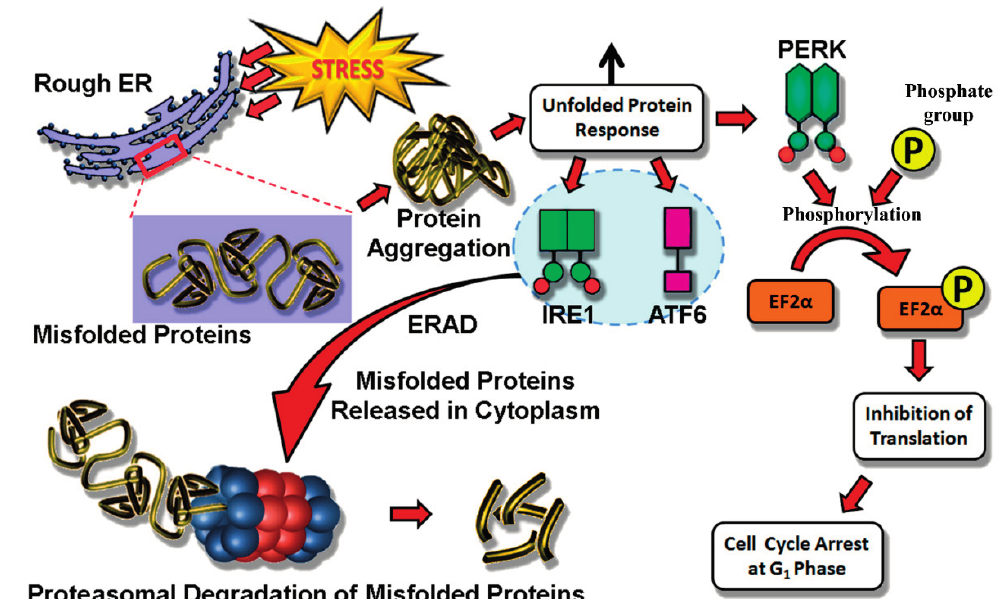
Figure 2. Molecular basis of the endoplasmic reticulum stress mechanism. Accumulation of misfolded proteins leads to upregulation of unfolded protein response (UPR) activating three pathways mediated by IRE1, ATF6 and PERK, respectively. Endoplasmic reticulum-associated degradation (ERAD) pulls out misfolded proteins into the cytoplasm and induces proteasomal